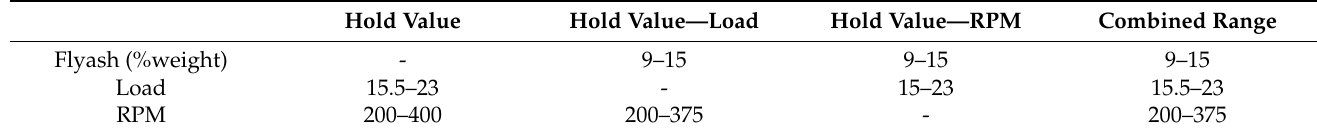
Table 10. Suitable range pertaining to minimum wear.